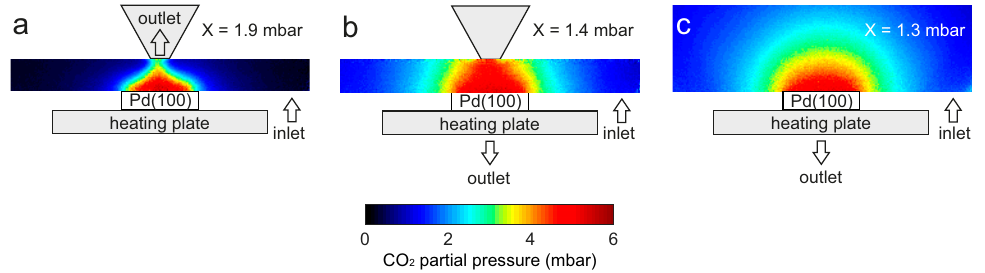
Figure 5. CO 2 distribution in the MTL regime for different flow configurations: ( a ) model ambient pressure X ‐ ray photoelectron spectroscopy (AP ‐ XPS) reactor where the nozzle is used as the gas outlet; ( b ) reactor with a nozzle but the gas outlet is located approximately 3 cm below the sample holder; ( c ) reactor without a nozzle, and the gas outlet is also located below the sample holder. All images are recorded under the same gas conditions, i.e., 6 mbar each of CO and O 2 and 138 mbar of Ar (total flow of 120 mL n /min). All images are 1000 laser ‐ shot averaged. In all configurations, the gas outlet is connected to both the vacuum pump and the MS. X denotes the CO 2 partial pressures measured by the MS.